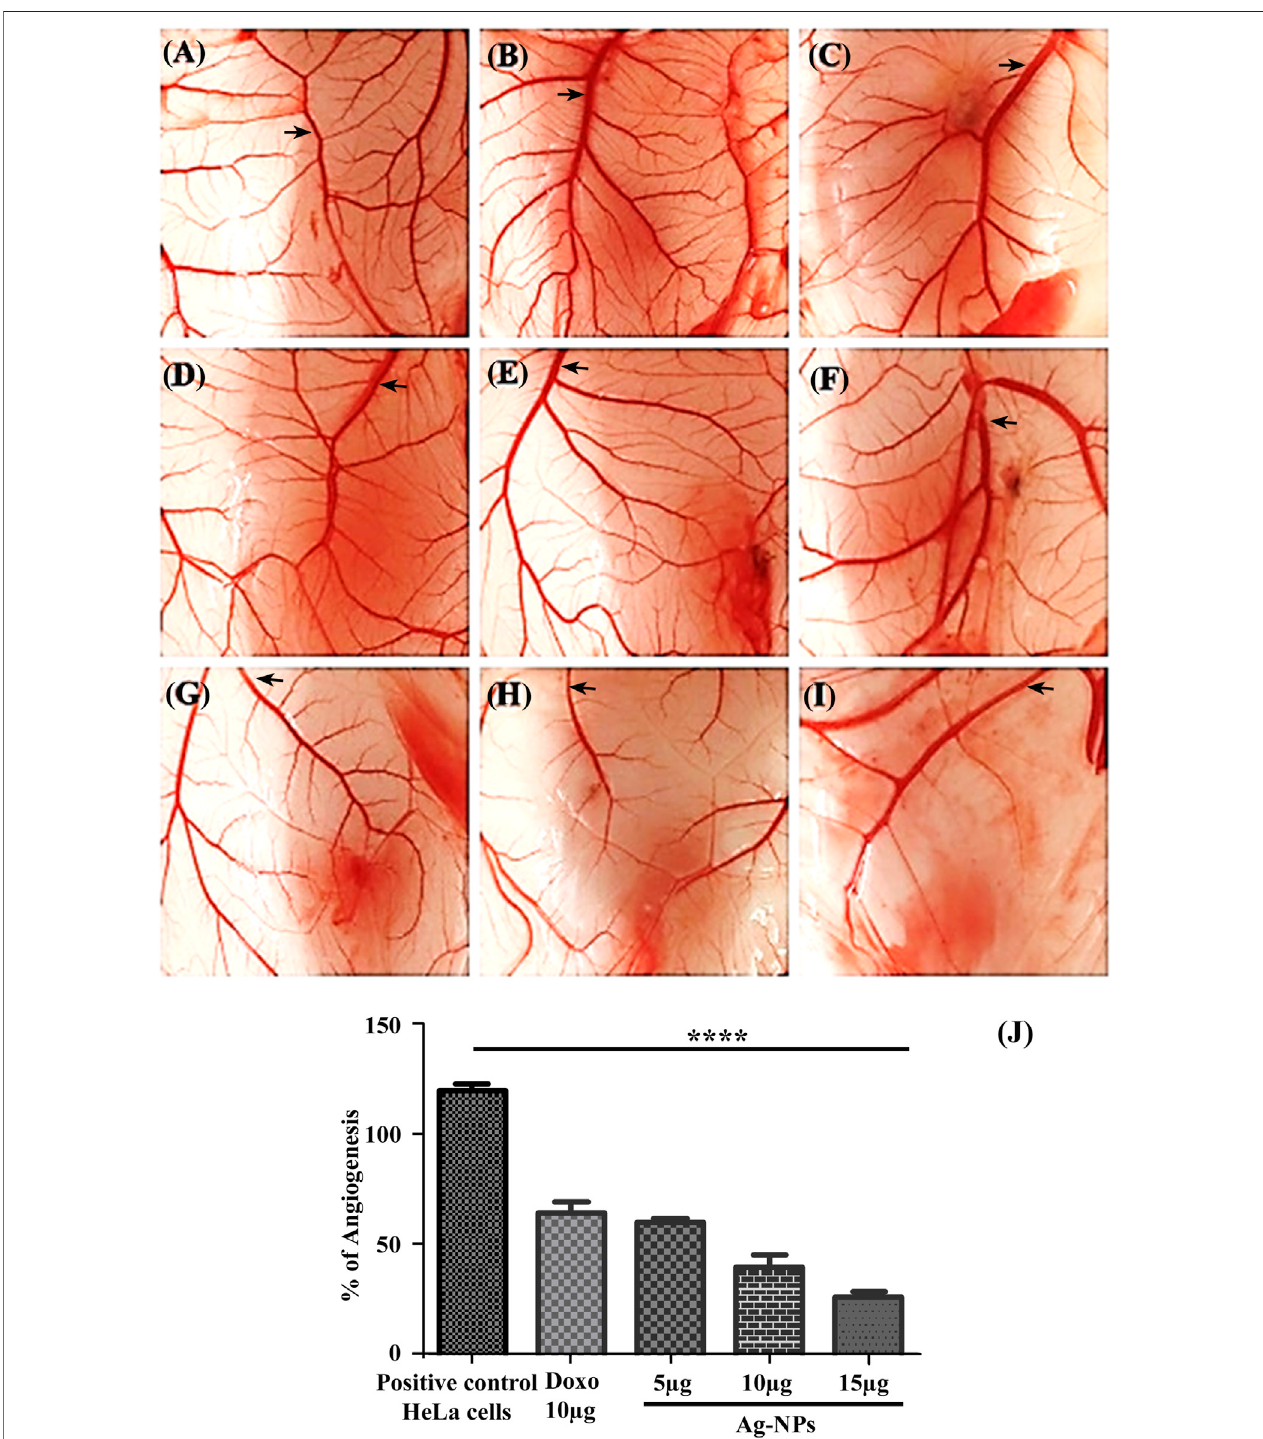
FIGURE 10| (A – J) Illustration of the CAM assay. (A) Untreated, (B) Treated only withHeLacells, (C) Exposed to 10 µg/ml doxorubicin, CAM treated with different concentrations of Ag-NPs — (D) 5 µg/ml, (E) 10 µg/ml, (F) 15 µg/ml, HeLa cells inoculated CAMs treated with Ag-NPs — (G) 5 µg/ml, (H) 10 µg/ml, (I) 15 µg/ml. (J) Bar histogram showing percentage of Angiogenesis.